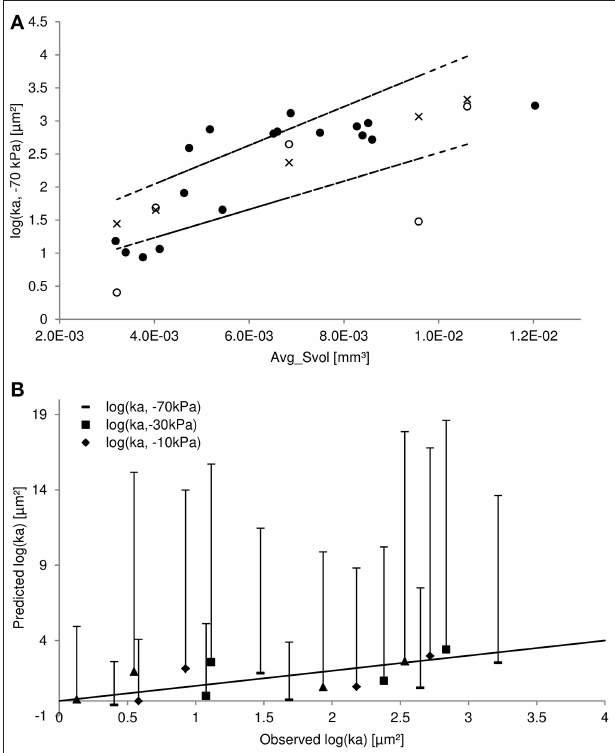
FIGURE 5 | (A) Logarithmic air permeability measured at a water matric potential of − 70 kPa (ka) vs. the average pore volume of the smallest pores (Avg_Svol). Black and white circles represent the observations from the calibration and validation data sets, respectively. Crosses represent the predicted validation data points and the dotted lines the 25 and 75% regression model quantiles. (B) The predicted logarithmic air permeability from the average pore volume of the smallest pores vs. the observed logarithmic air permeability. Error bars represent the 75% regression model